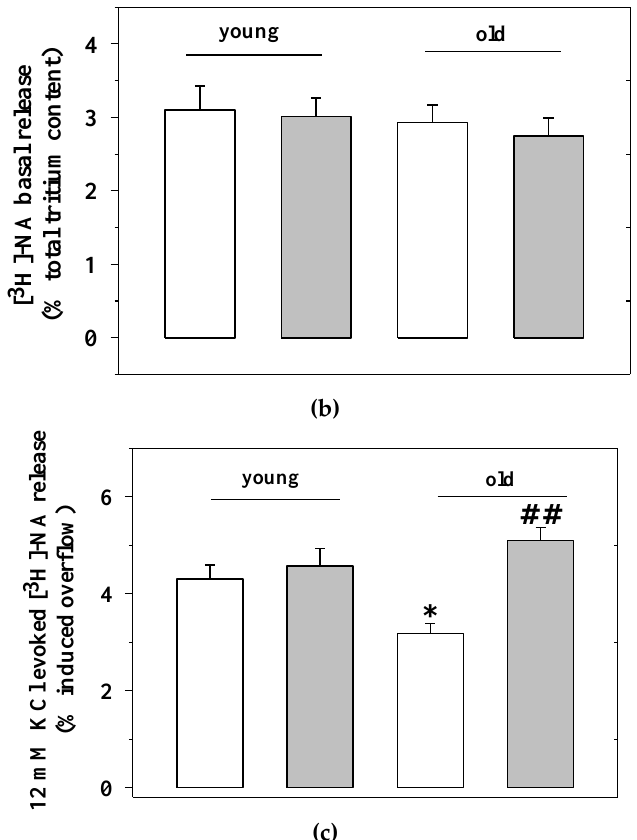
Figure 4. Noradrenaline uptake and release from cortical synaptosomes of young and old mice: effects of chronic EAm treatment. ( a ) total [ 3 H]noradrenaline ([ 3 H]NA) content (expressed as nCi) in cortical synaptosomes from EAm-untreated (empty bar) or EAm-treated (gray bar) young and old mice. ( b ) spontaneous basal release (expressed as percentage of tritium in the first collected superfused fraction, with respect to the total tritium synaptosomal content) in cortical synaptosomes from the four animal groups. ( c ) 12 mM KCl-evoked [ 3 H]noradrenaline release (expressed as percentage of tritium released over the basal outflow with respect to the total tritium synaptosomal content) in cortical synaptosomes from the four animal groups. Data represent the mean ± S.E.M. from nine untreated young mice, eight EAm-treated young mice, nine untreated old mice, nine EAm-treated old mice, from both of the two trials. Statistical analysis was performed by applying ANOVA followed by the Tukey’s Multiple Comparison test. * p < 0.05 vs. EAm-untreated young mice; ## p < 0.01 vs. EAm-untreated old mice.